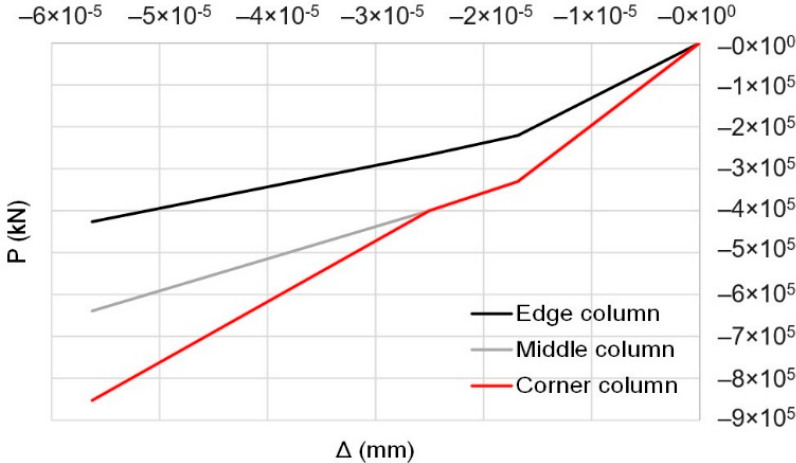
Table 8. Properties of horizontal link element.